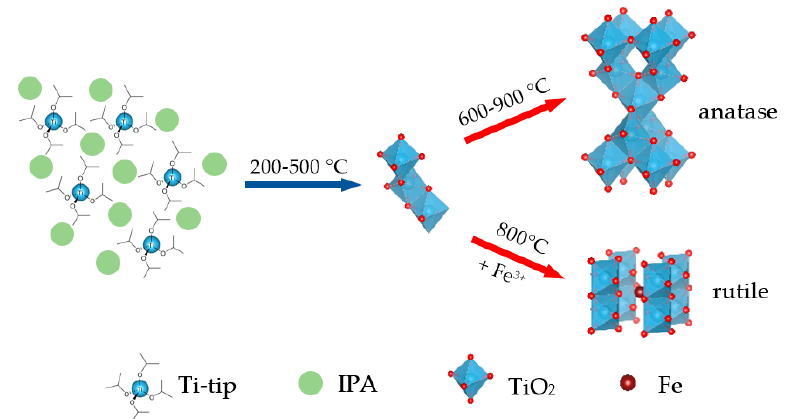
Figure 6. Graphical representation for the formation of anatase TiO 2 and rutile TiO 2 doped with Fe.